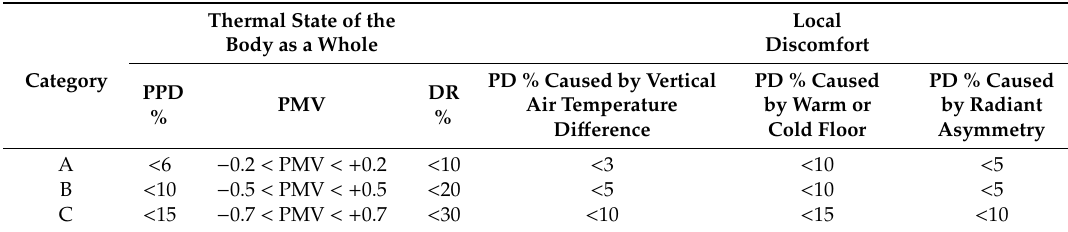
Table 3. Categories of thermal environment [4].